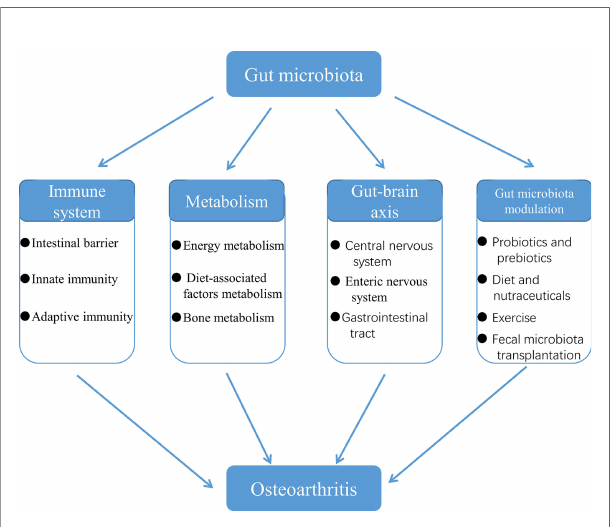
FIGURE 9 | The role of the gut microbiota in the initiation and progression of